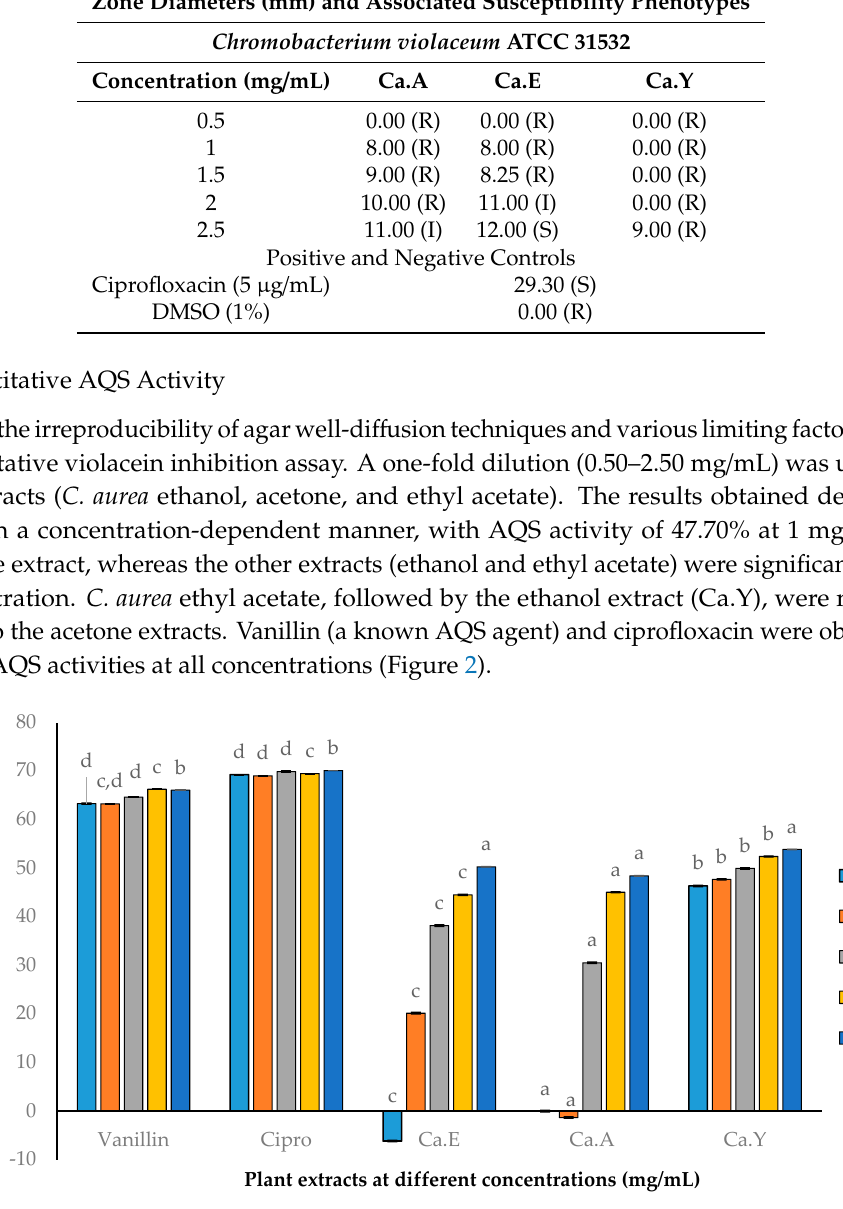
Figure 2. Violacein production by Chromobacterium violaceum ATCC 12472 at di ff erent concentrations. C. aurea extracts: Ca.E—Ethanol, Ca.A—Acetone, and Ca.Y—Ethyl acetate extract. Data presented are mean ± SD, n = 3. Di ff erent letters represent statistical di ff erence at p -value = 0.05 (GLM: generalized linear model and LSD: least significant di ff erence).